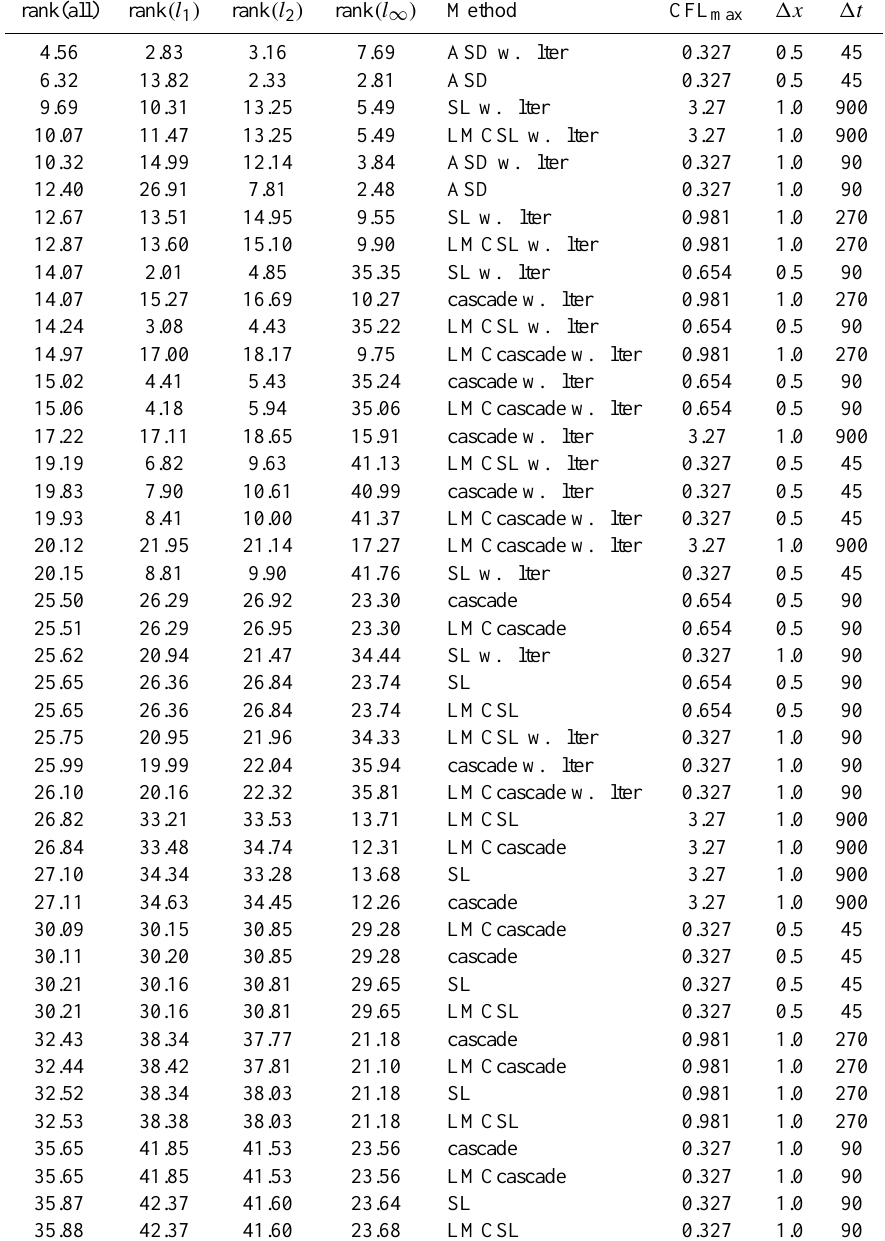
Table 2. Ranking results for the slotted cylinder with rural chemistry. Showing rank of the ranked error measures, rank of error measure l 1 , l 2 , and l ∞ followed by method, maximum Courant number, grid resolution, and time